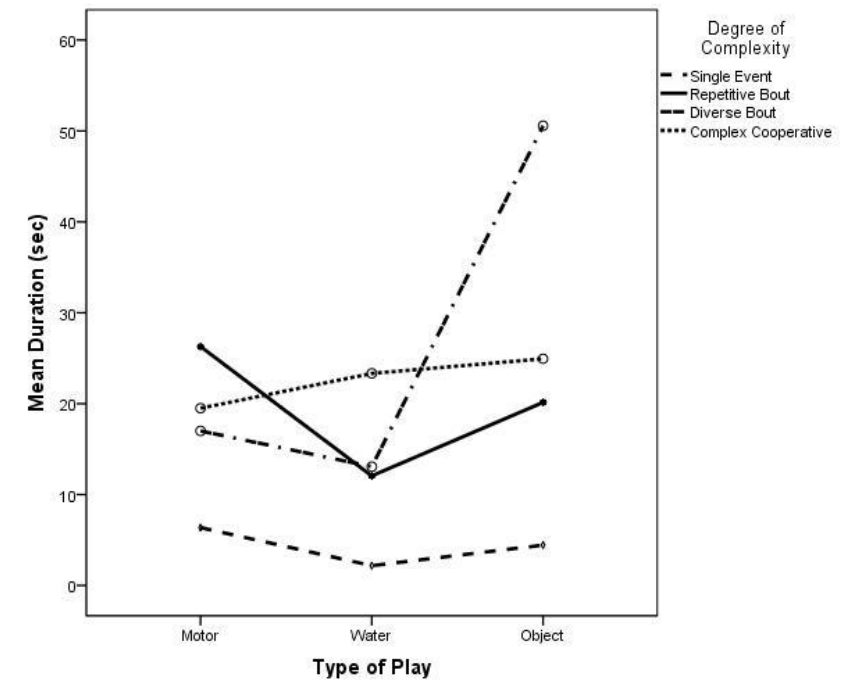
Figure 6. Mean durations (sec) of the interaction between type of play bout and complexity of play .